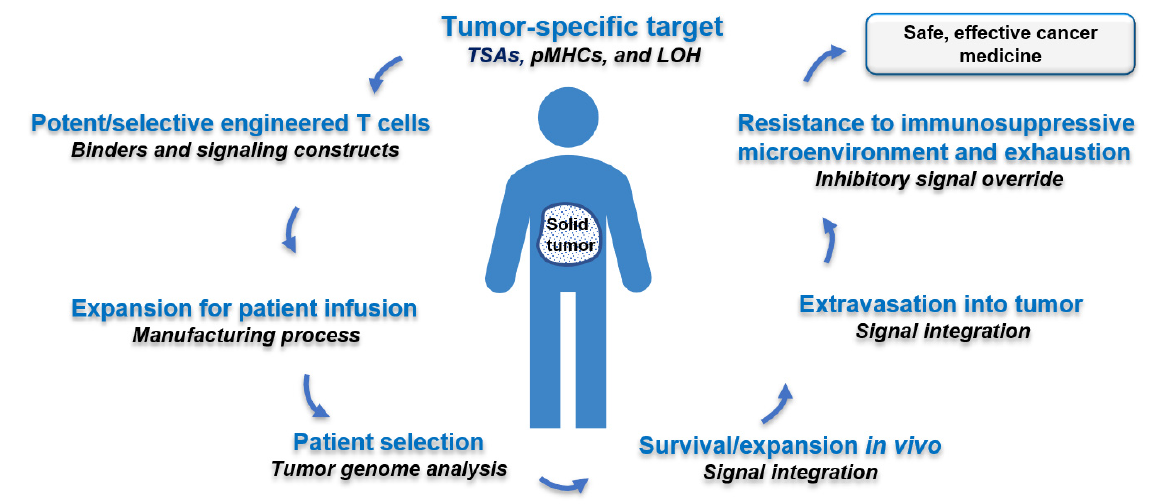
Figure 2. Cell therapy for solid tumors: step-wise requirements for success. This diagram illustrates the number and complexity of the steps required to achieve efficacy. Many of these steps can be studied in vitro ; for others (e.g., extravasation), in vitro models are inherently problematic. TSA, Tumor Specific Antigen; pMHC, peptide-major histocompatibility antigen; LOH, loss of